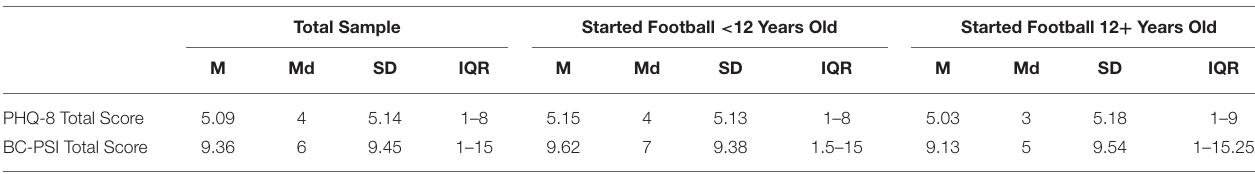
TABLE 4 | PHQ-8 and BC-PSI total scores across football exposure groups. Total